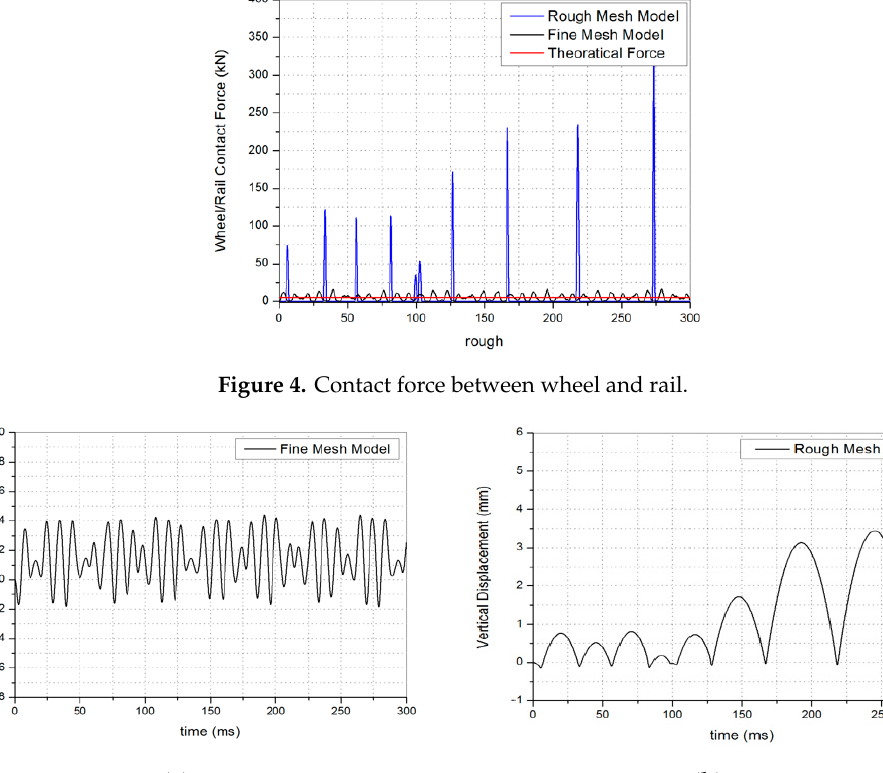
Table 1. The specification of 3-piece bogie frame [21].